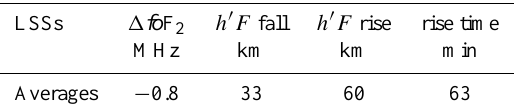
Table 3. Mid-latitude LSSs of LS-TIDs (6 plots). Table 4. Very fast